Question: Describe this figure in one sentence.
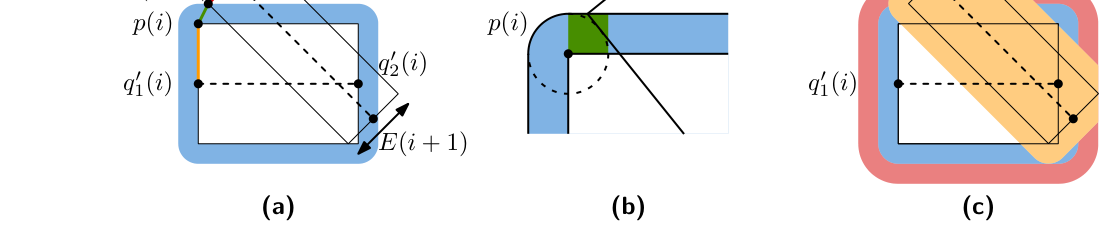
Answer: Constructions for Lemma 23 and 25. (a) All points are inside the (horizontal) bounding box at time i and hence cannot have moved outside the blue border at time i + 1. We bound the length of the three colored line pieces to bound the speed of q1. (b) When a point p on the minor axis of the horizontal box reaches the major axis of the box at i + 1, the minor axis of the same box must touch the green square. (c) At time i + 2 all points cannot have moves outside the width-2 red border around the box at time i, and at most one unit outside the box at time i + 1 (yellow).